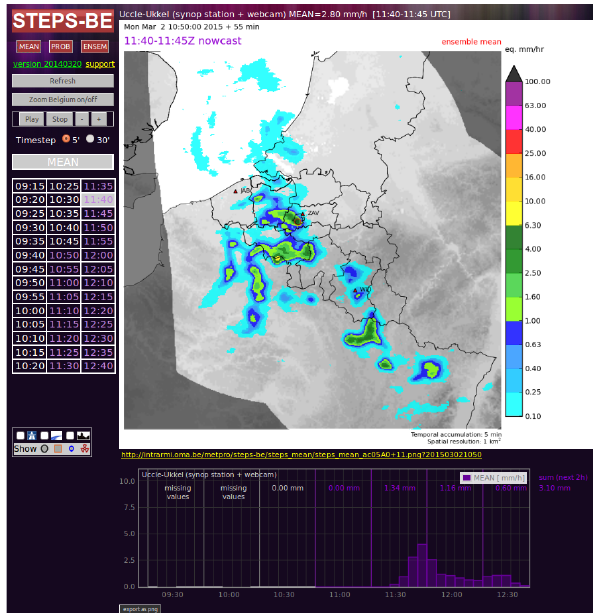
Figure 1. Web platform of STEPS-BE showing the ensemble mean